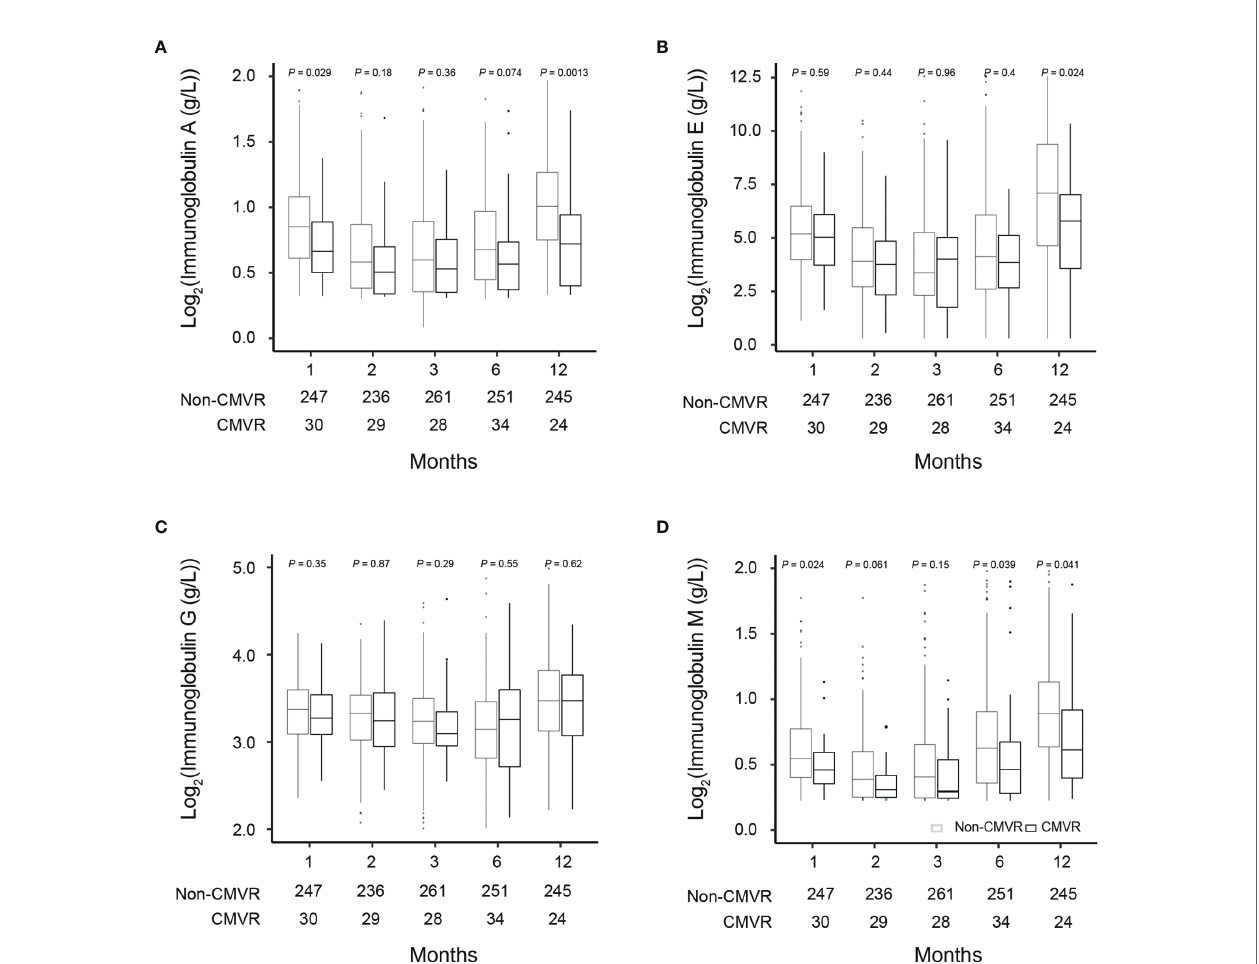
FIGURE 3 | Comparisons of the immunoglobulin (Ig) levels in severe aplastic anemia patients who did and did not develop CMVR at 1, 2, 3, 6, and 12 months after hematopoietic stem cell transplantation (A – D) . The number of samples used in each time point was indicated in each fi gure.